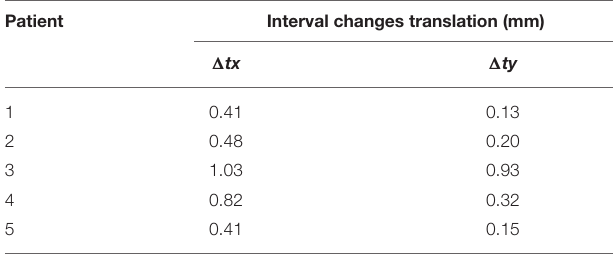
TABLE 5 | RMSE of transformation parameters of the brain MRI.